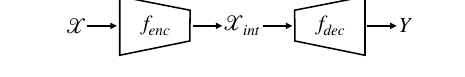
Figure 3. Visualization of an abstract deep learning model f